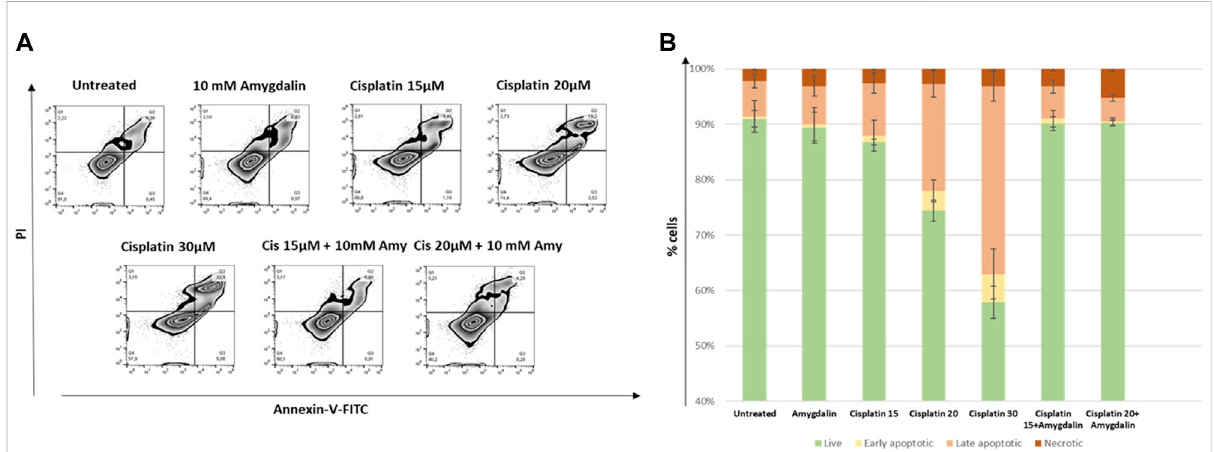
FIGURE 3 The effect ofamygdalin inthe apoptosis inducedby cisplatinin MCF-12F cells. (A) Annexin V/PI staining was employed for the evaluation of the apoptotic effect (% compared to control) of 15 and 20 μ M cisplatin with or without 10 mM amygdalin for 48 h. Zebra plot diagrams of the % of live (Q4), early (Q3), late apoptotic (Q2) and necrotic cells (Q1) in each stimulation are reported. (B) Stacked bar diagrams depicting the changes in the aforementioned populations. Data of three independent experiments are shown.